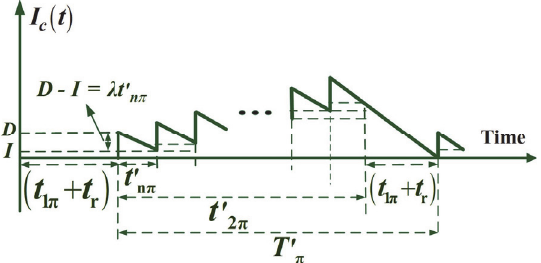
Fig. 5. The buyer stock level in the proposed